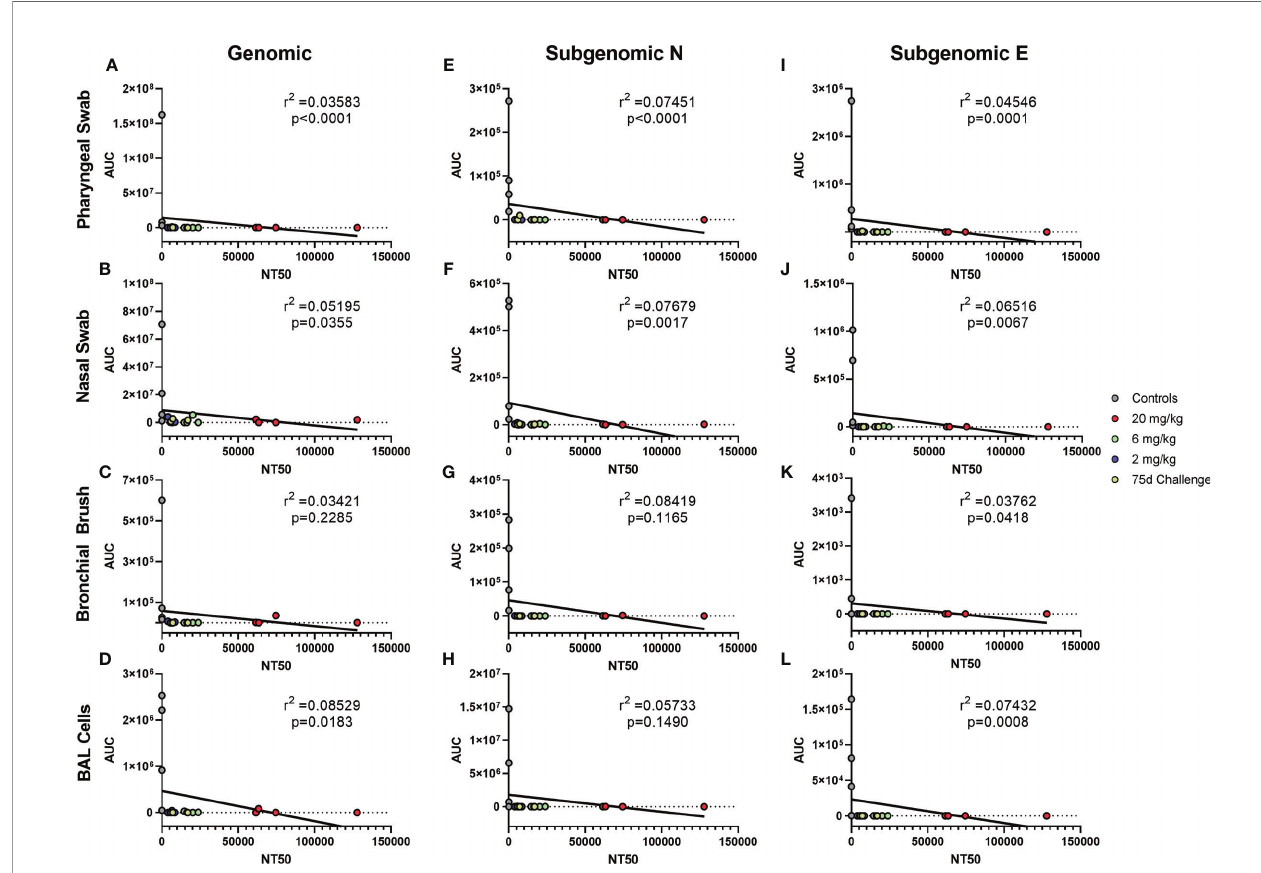
FIGURE 4 | Correlations between Serum Antibodies and Viral Loads. Viral loads were correlated with neutralization capacity of serum collected 1 day post challenge from pharyngeal swabs (A, E, I) , nasal swabs (B, F, J) , bronchial brushes (C, G, K) and BAL cells (D, H, L) assessed by RT-qPCR for genomic N (A – D) , subgenomic N (E – H) , and subgenomic E (I – L) content. The NT 50 of each was calculated via pseudovirus neutralization assay presented as reciprocal serum dilution. Nonparametric correlation with linear regression performed to determine the r2 value for each